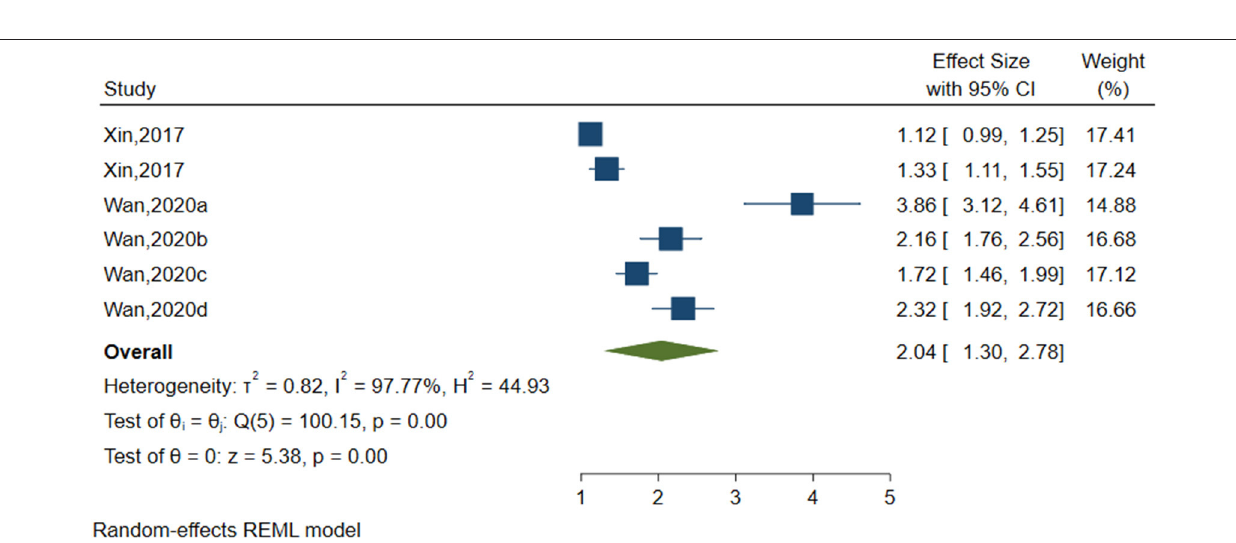
FIGURE 8 | Forest plot of studies including negative coping style